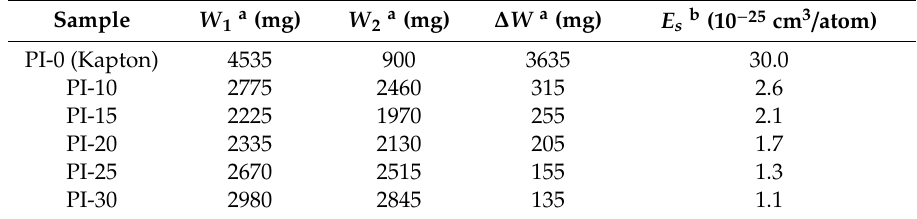
Figure 10. Weight loss of POSS ‐ PI films during atomic ‐ oxygen (AO) erosion (AO fluence: 2.16 × 10 21 atoms/cm 2 ). Table 3. AO effects and erosion yields for POSS ‐ PI films.